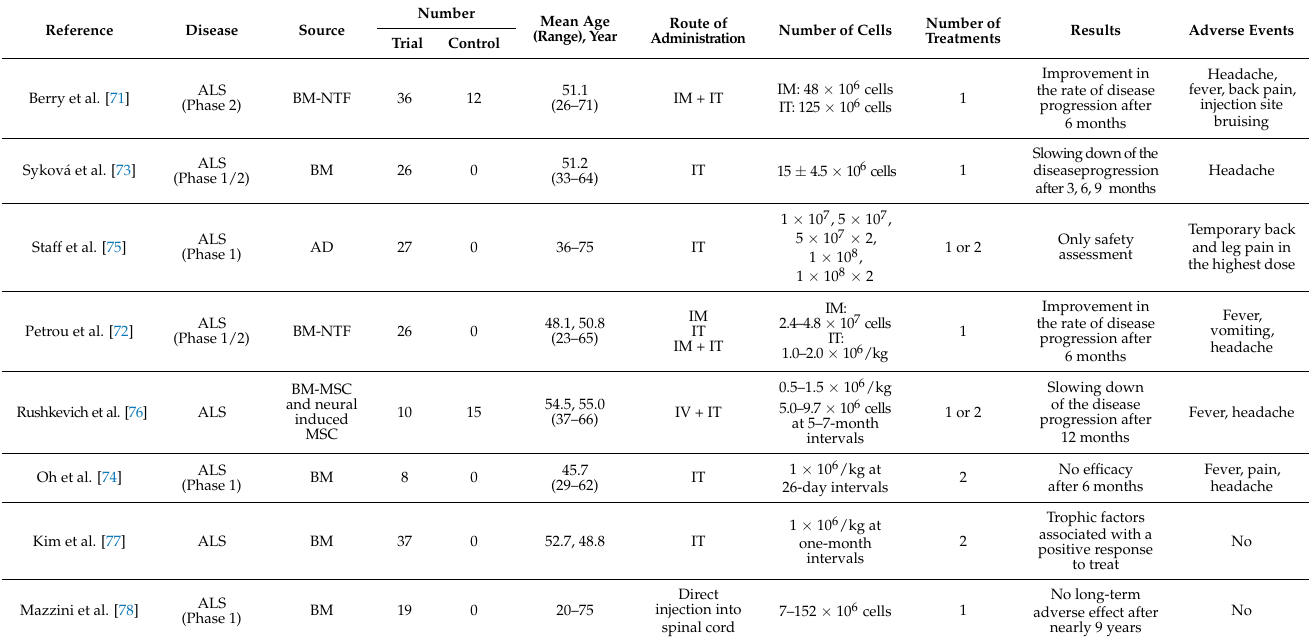
Table 4. Summary of recent clinical trials using MSCs for